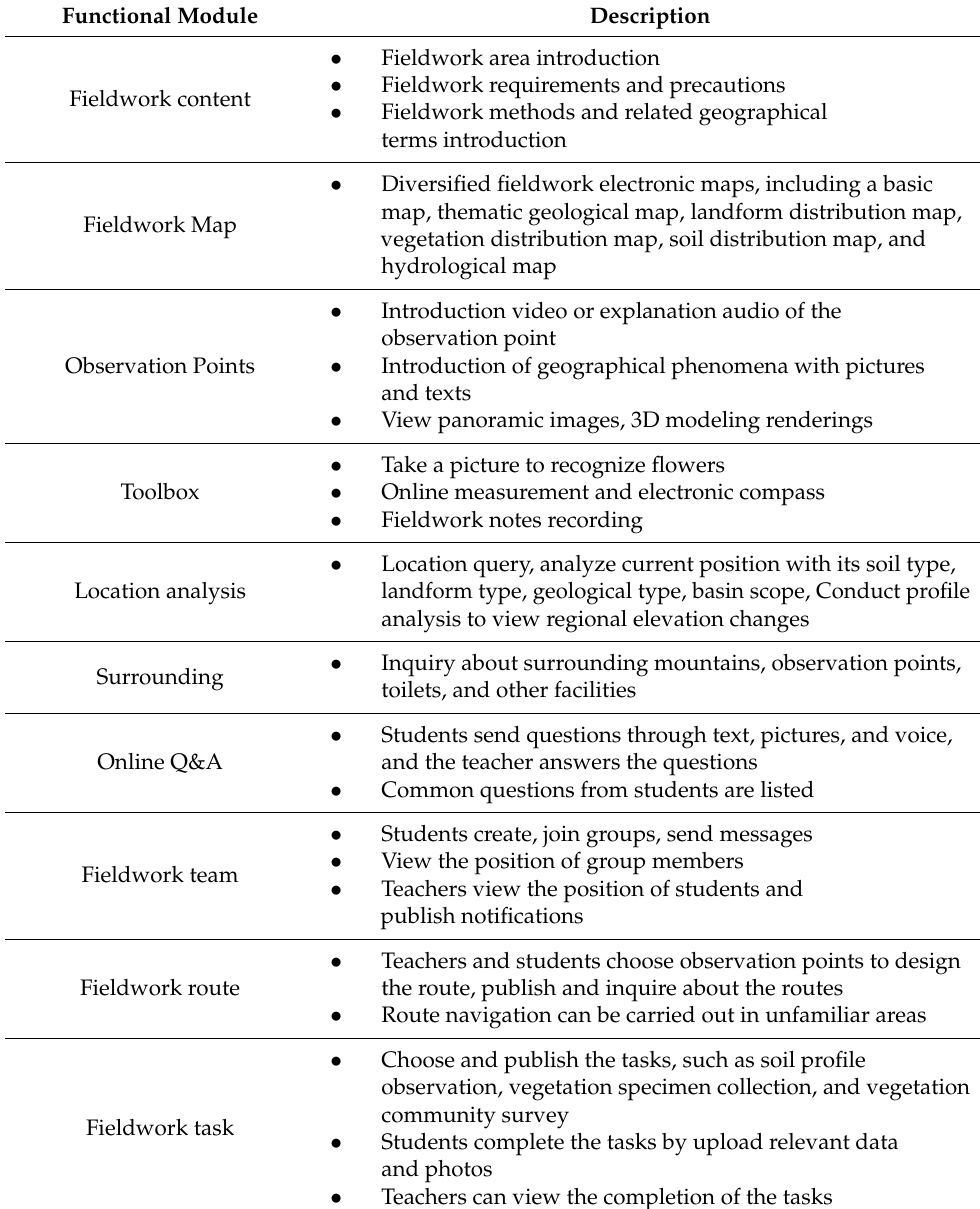
Table 2. Main functional modules in the mobile application of the fieldwork